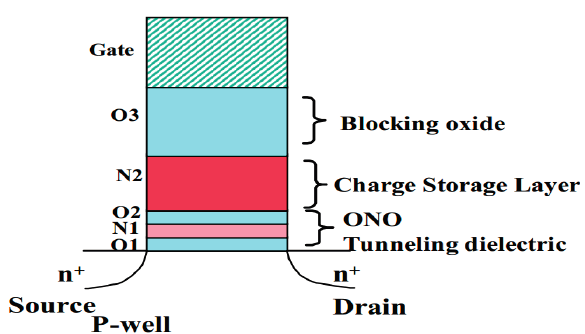
Figure 13. Structure of the n-channel BE-SONOS using ultra-thin ONO tunneling dielectric. Reused with permission from [55], Copyright 2003,